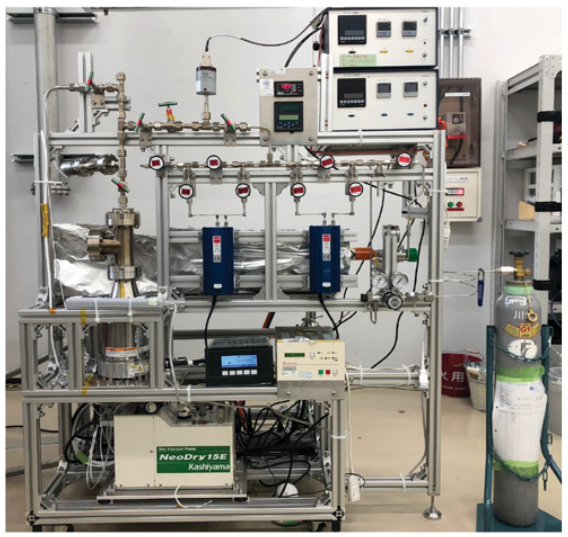
Figure 11. Vacuum system for confinement of 3 He and Rb in the glass cell of the spin